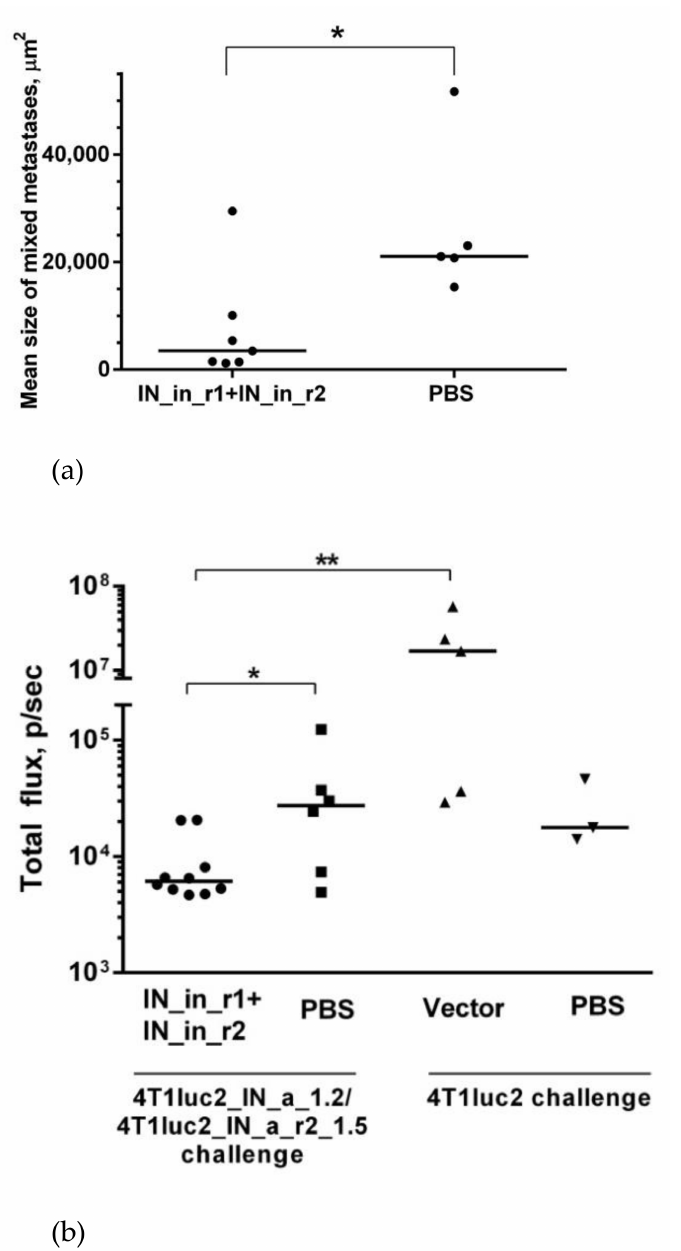
Figure 15. DNA immunization with RAL resistant IN variants suppresses metastatic activity of IN expressing murine adenocarcinoma cells. Assessment of infiltration of tumor cells into the lungs by ex vivo BLI, where line bars represent the median of total flux from the lungs of mice DNA- immunized with IN variants ( n = 10) or mock-immunized with PBS ( n = 6) and implanted with IN-expressing 4T1luc2 cells ( a ); mean size of the lung metastases, µ m 2 , in mice DNA-immunized with IN variants or mock-immunized with PBS and implanted with 4T1luc2 cells expressing IN_a or IN_a_r2 ( b ). Number and size of metastases were calculated in 25 high power (400 × ) microscope fields of hematoxylin–eosin-stained slides by computer-assisted morphometry. Line bars represent median values. *— p < 0.05, **— p < 0.01, no p values indicate no statistically significant differences; Kruskal–Wallis, Mann–Whitney